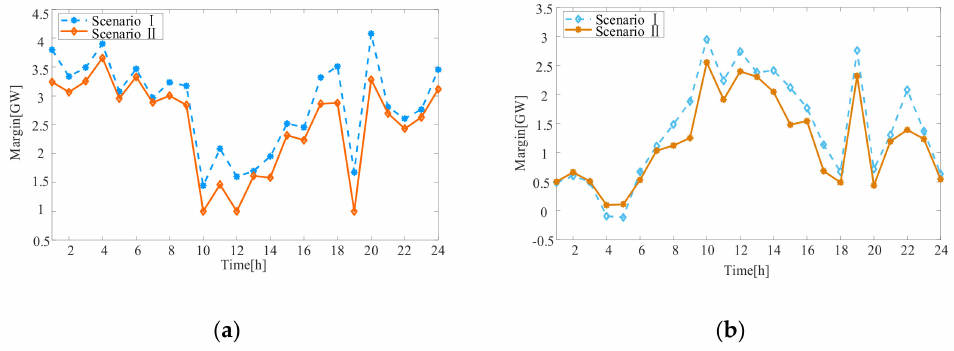
Figure 9. Comparison of flexibility margins between the two scenarios. ( a ) Upward flexibility margin. ( b ) Downward flexibility